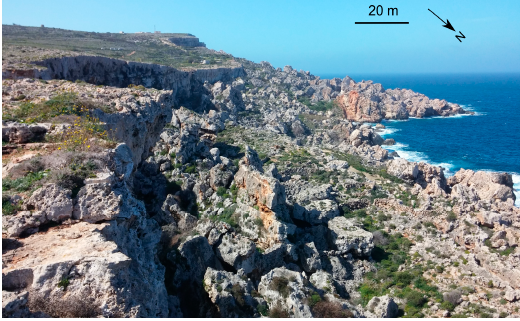
Figure 7. Marfa Ridge site seen from the north.